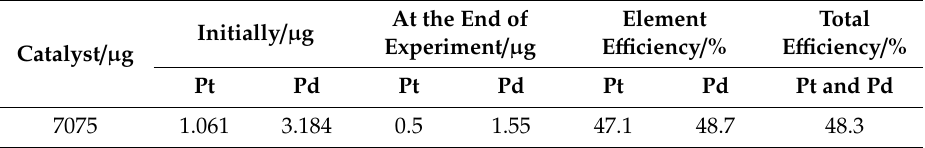
Electrochemical dissolution of spent automotive catalyst in 1 M HCl